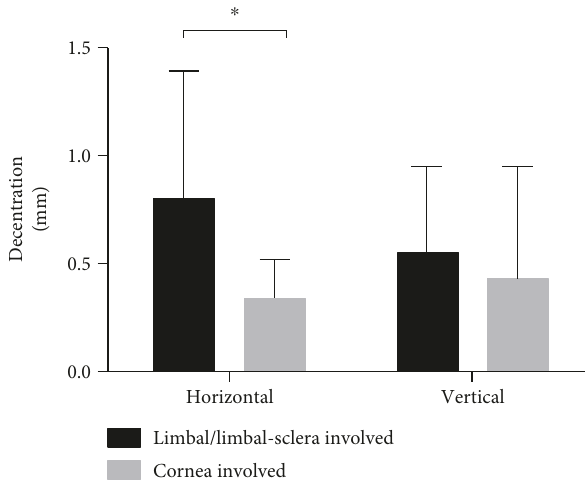
Figure 1: Horizontal and vertical decentration of IOLs in the limbus/limbus-sclera-involved group and the only-cornea- involved group. Horizontal decentration was signi fi cantly higher in the limbus/limbus-sclera-involved group than in the cornea- involved group ( P = 0 040 ). ∗ P < 0 05 .